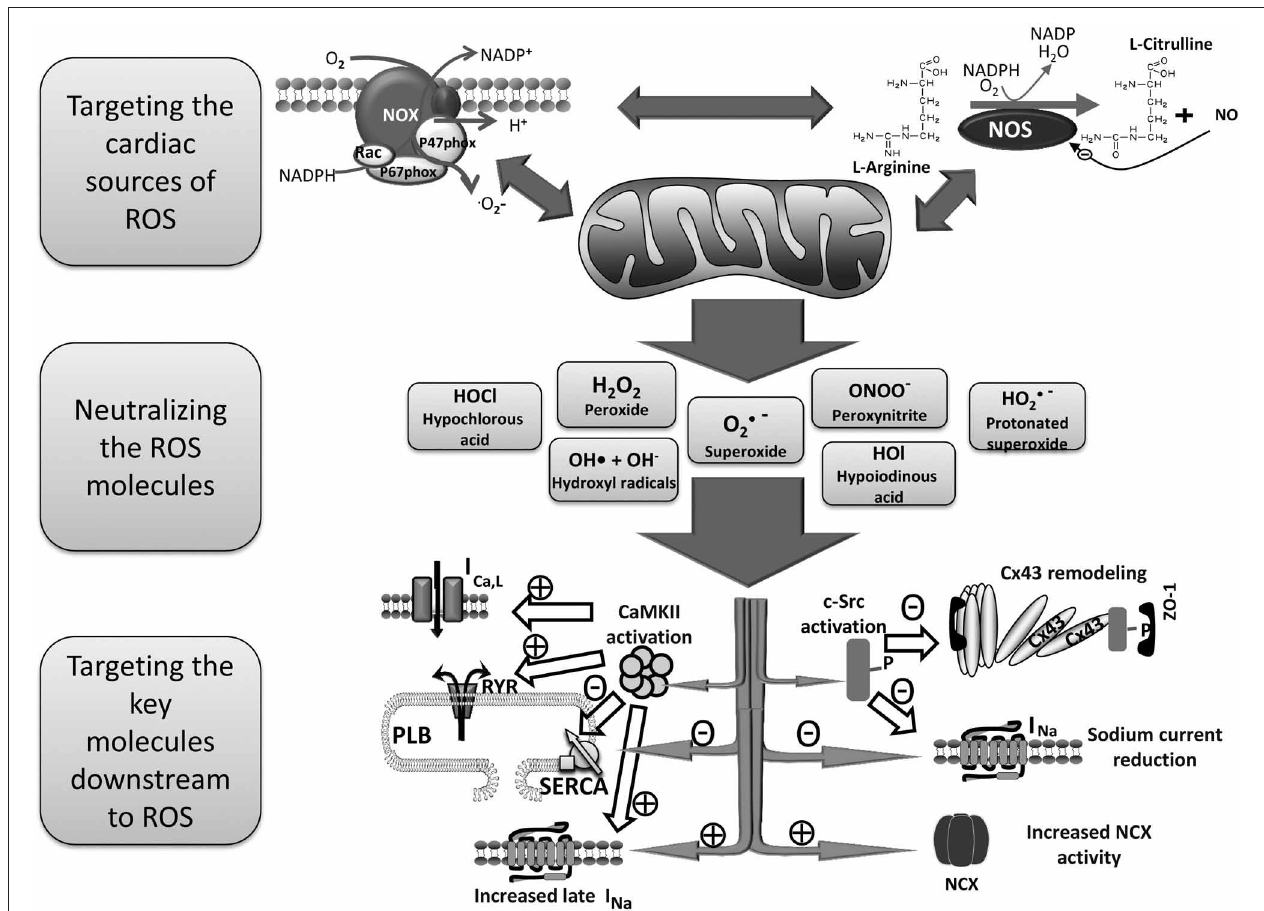
FIGURE 1 | Schema for the treatment of AF by reducing ROS. Mitochondria, NADPH oxidase and uncoupled NOS are probably the most important cardiac sources of excess ROS. There are positive feedbacks among these sources in a way that activation of one results in increased activity and ROS production of the others. A variety of ROS molecules are produced as a result of activation of those sources of cardiac ROS which then oxidize proteins and lipids resulting in arrhythmia in several ways. Three main therapeutic strategies to prevent ROS induced